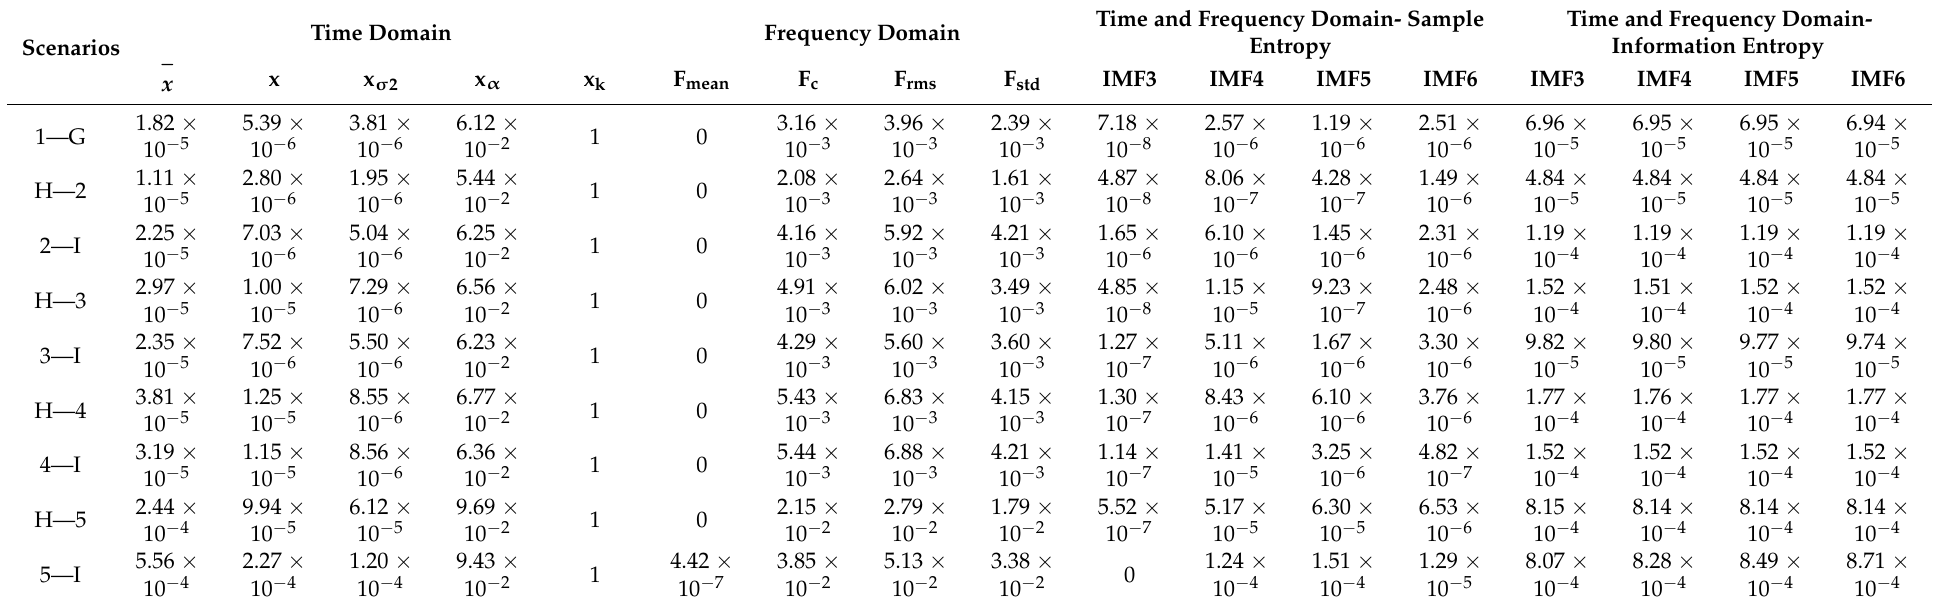
Table 8. Three domain